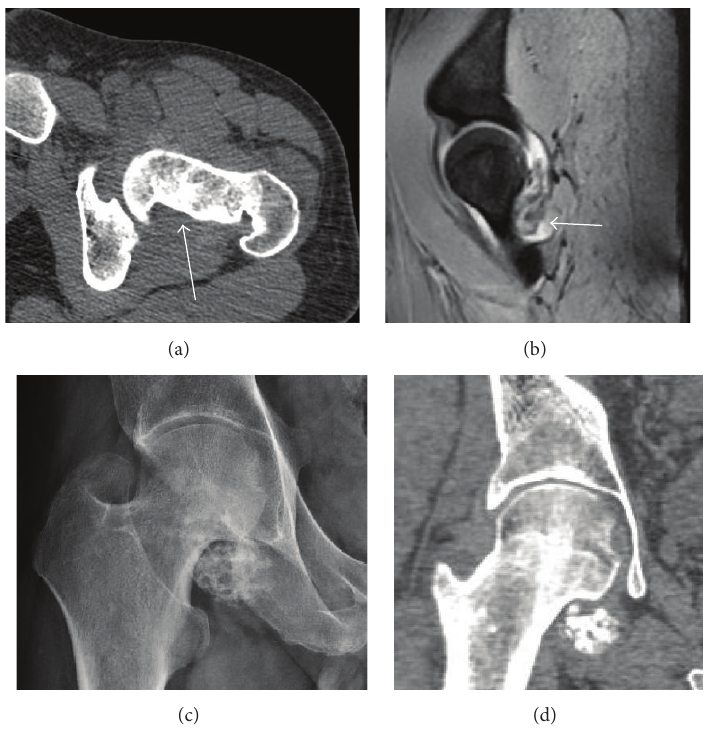
Figure 7: (a) Axial CT image of pigmented villonodular synovitis eroding the posterior cortex of the femoral neck. (b) Sagittal T 2 ∗ gradient echo image showing a posterior soft tissue mass with hypointense areas secondary to hemosiderin deposition. (c) X-ray film and computed tomography (d) in synovial